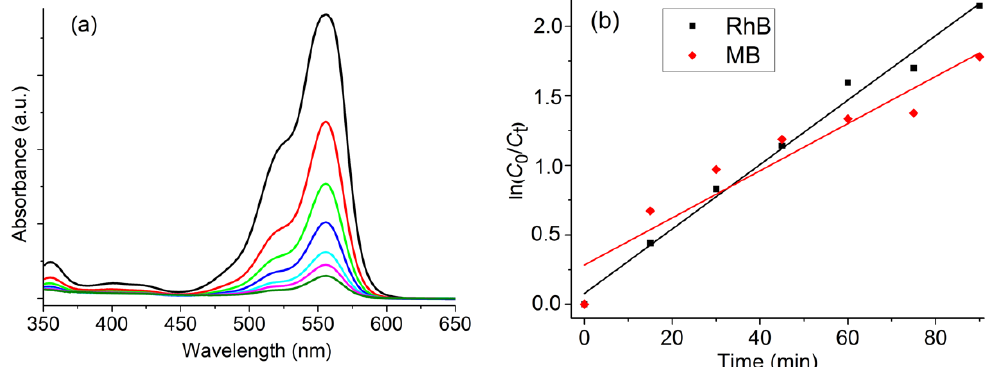
Figure 7. ( a ): Evolution of the absorbance of RhB over time (black (start), red (15 min after H 2 O 2 addition), green (30 min), blue (45 min), cyan (60 min), pink (75 min), olive (90 min) in H 2 O at pH = 7 and 25 ◦ C; 0.024 mmol of [Co(TTMPP)], C dye = 0.05 mmol, C H2O2 = 0.06 mmol. ( b ): Changes in ln( C t / C 0 ) over time for both dyes.